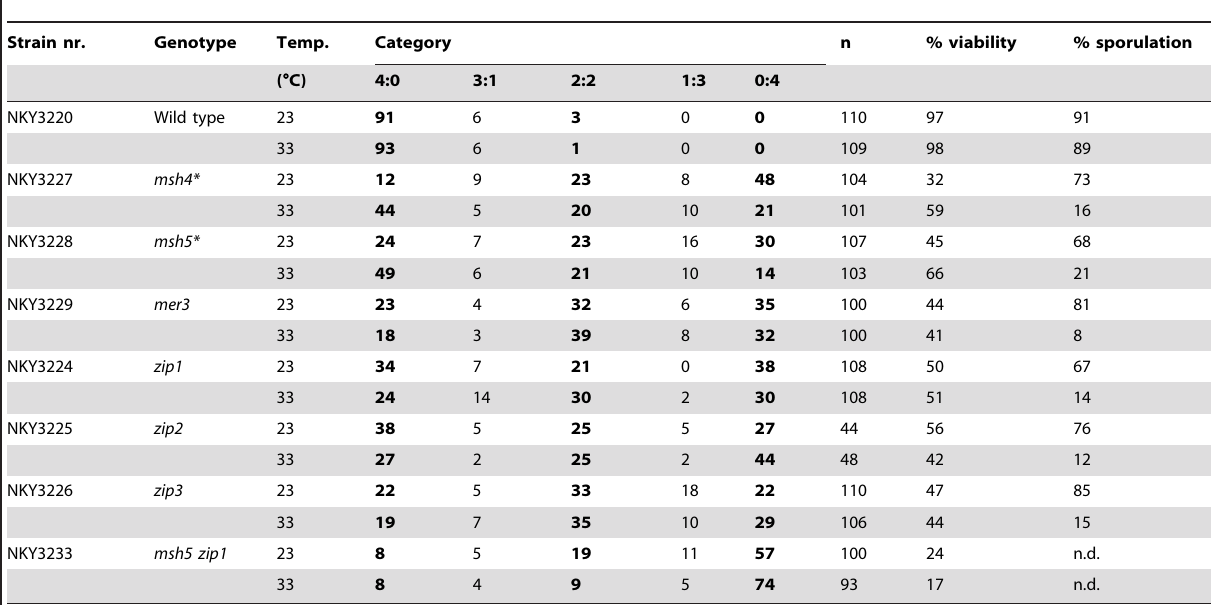
Table 2. Gamete viability and sporulation frequencies in zmm mutants of SK1.